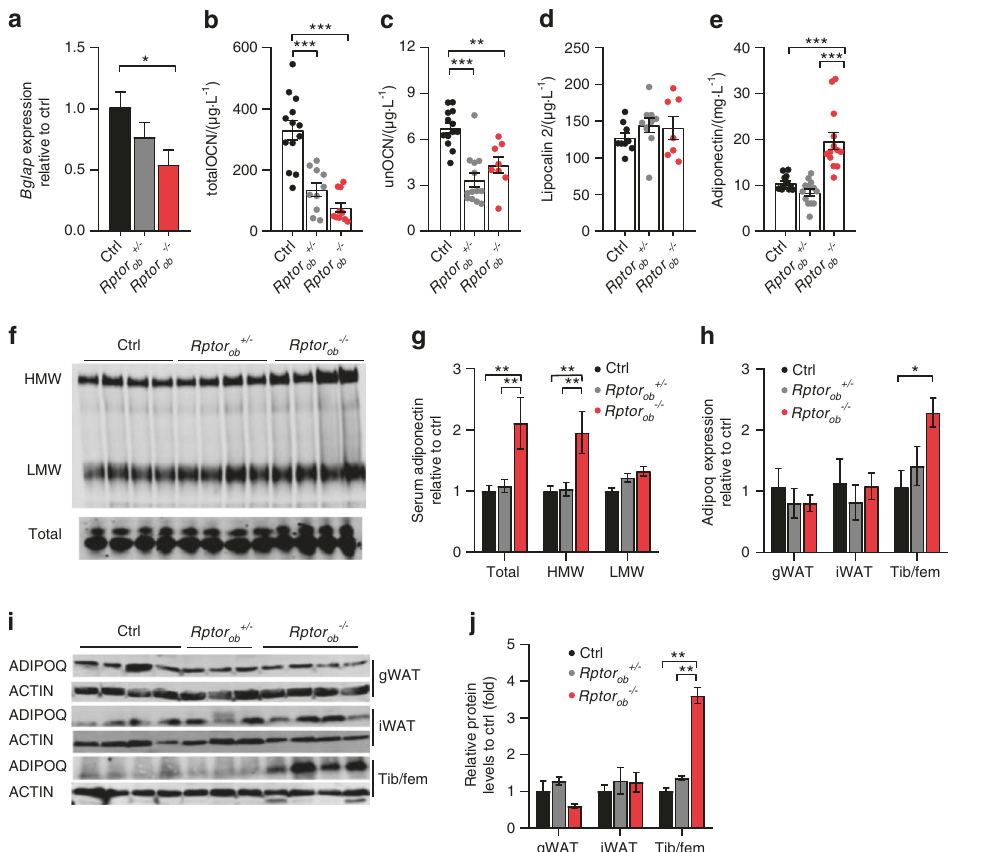
Fig. 3 Improvements in glucose metabolism observed in NCD-fed Rptor ob − / − mice occur independently of osteocalcin. a Bglap gene expression, normalized to Actb , in fl ushed long bones (femur/tibia, n = 3 – 4/genotype) from 9-week-old mice. b Serum OCN (total) levels ( n = 10 – 13/genotype). c Serum unOCN levels ( n = 8 – 13/genotype). d Serum lipocalcin-2 levels ( n = 7 – 10/genotype). e Serum adiponectin levels ( n = 13/genotype). f , g Western immunoblot analysis and quanti fi cation of high molecular weight (HMW), low molecular weight (LMW), and total adiponectin levels in serum ( n = 4/genotype). h Adipoq gene expression, normalized to Actb , in gWAT, iWAT, and whole long bone (tibia/ femur) samples ( n = 3 – 5/genotype). i Levels of total adiponectin protein expression in gWAT, iWAT, and tibia/femur samples ( n = 3 – 4/ genotype) and j Quantitative analysis of adiponectin protein levels, relative to ACTIN, from i . Data are expressed as mean ± SEM. * P < 0.05, ** P < 0.01, *** P < 0.001, one-way ANOVA with Tukey ’ s post hoc